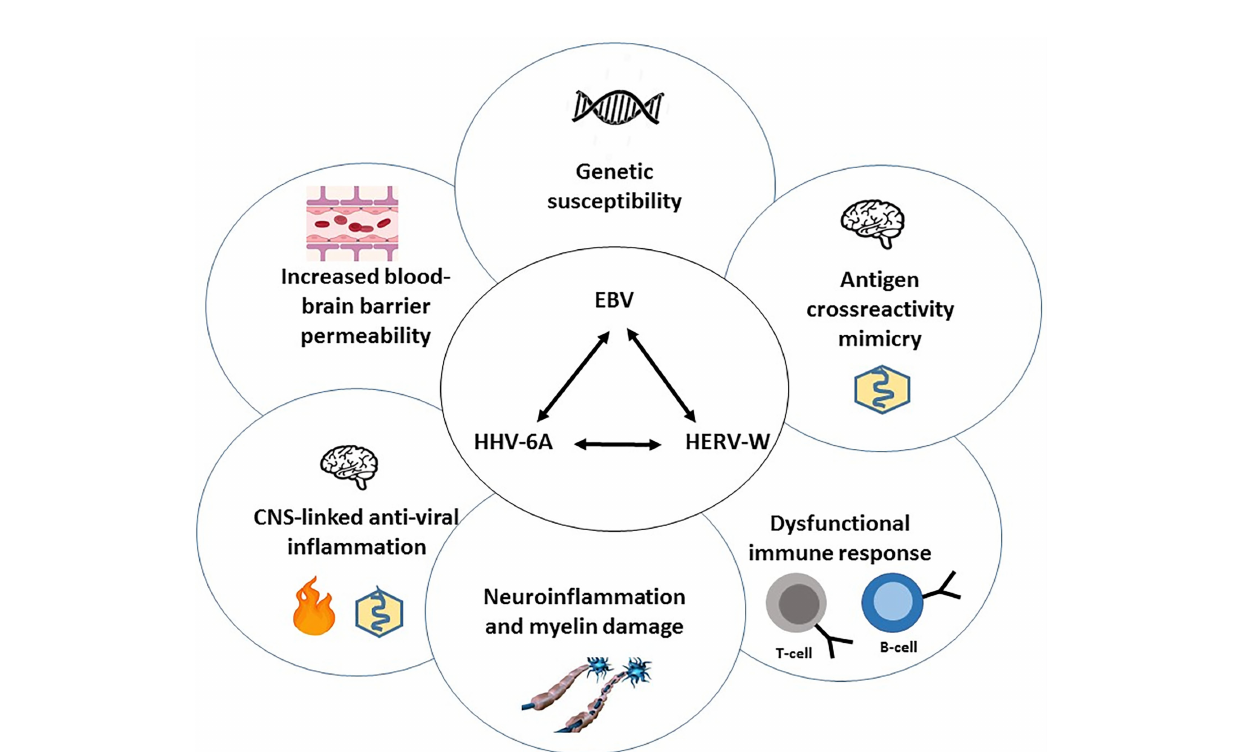
FIGURE 1 | Overview of the central viral cascade causing dysregulation of immune responses, localized CNS-in fl ammation and neuronal damage underlying MS- pathogenesis. A central role is proposed for Epstein-Barr virus (EBV), a persistent and frequently reactivating virus, that is associated with Multiple Sclerosis (MS) in genetically susceptible individuals (HLA-DRB*1501). Following ( “ stress ” -induced) EBV reactivation in quiescent latency-I EBV-carrying B-cells in lymphoid tissues near the CNS, EBV-encoded gene products, - such as EBER1, miRNA and LMP1 in exosomes secreted by viable reactivating B-cells (latency-II/-III) and EBNA1-DNA complexes released from apoptotic EBV+ B-cells and possibly forming reactive immune complexes with locally produced anti-EBNA1-IgG -, together trigger anti-viral T-/B-/NK-cell-, antibody- and cytokine responses (Type-I IFN, TNF- a , IL-6, -10, -17A) causing localized in fl ammation. This is associated with spread of viral products, immune complexes, cytokines and the in fi ltration of (cross-)? reactive lymphocytes via a compromised blood-brain barrier causing aberrant activation of CNS-resident microglia and astrocytes and damage to oligodendrocytes (ODCs), leading to CNS in fl ammatory lesions as characteristic feature of MS. EBV itself and in fl ammatory cytokines may trigger the expression of endogenous germline-encoded viral sequences (MSRV or HERV-K/-W and HHV6A) in reactive lymphocytes and in in fl ammatory glia/astrocytes/ODC, which further enhance the localized CNS in fl ammation. In this in fl ammatory milieu, shared epitopes between (endogenous) viral and neuronal self-antigens may trigger autoimmune responses in susceptible individuals (HLA-DRB*1501), thus perpetuating CNS in fl ammation and causing pathogenic microglia activation and neuronal damage in an episodic (CIS), recurrent (RRMS) or progressive (SPMS, PPMS) virus-driven and auto-reactive pathogenic process. Interference with virus-driven in fl ammatory signaling, reconstitution of a quiescent immunological balance, remyelination and repair of damaged neurons are therefore key to future treatment and curative approaches in